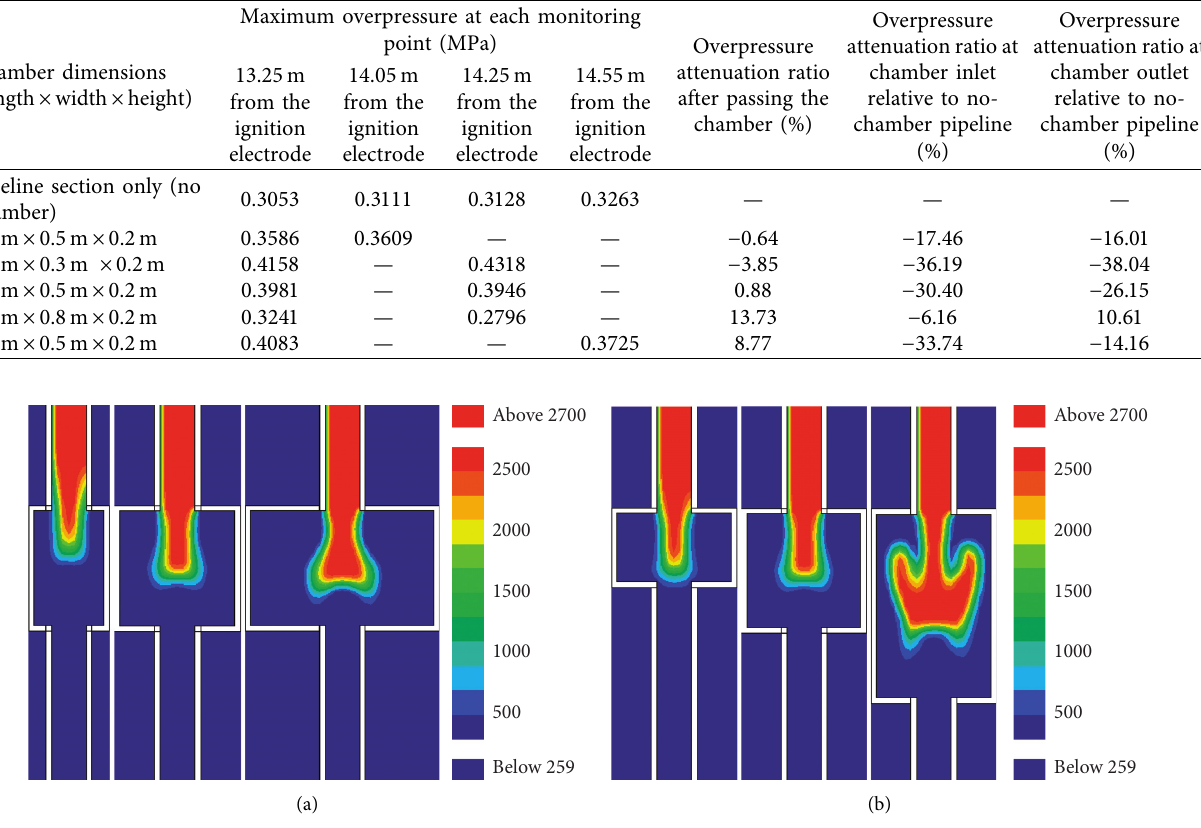
Figure 7: Propagation of explosion flame in chambers with different geometric parameters. (a) Variable-width chambers (0.2m high and 0.5m long); (b) variable-length chambers (0.2m high and 0.5 m wide).